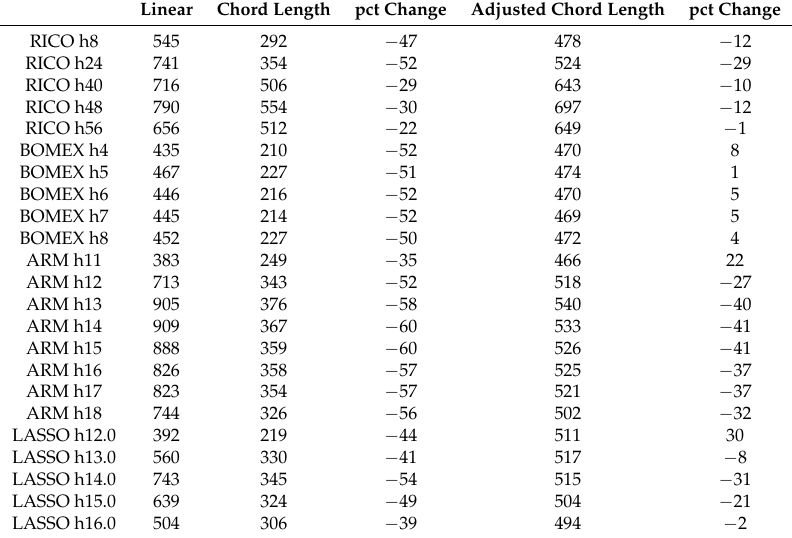
Table 1. The area-weighted average cloud size for different instances, calculated using the actual cloud area, the chord length, and the adjusted chord length, together with the relative error for the latter two methods. For RICO and BOMEX, the simulation time is shown. For ARM and LASSO, the local time is shown. Linear Chord Length pct Change Adjusted Chord Length pct Change RICO